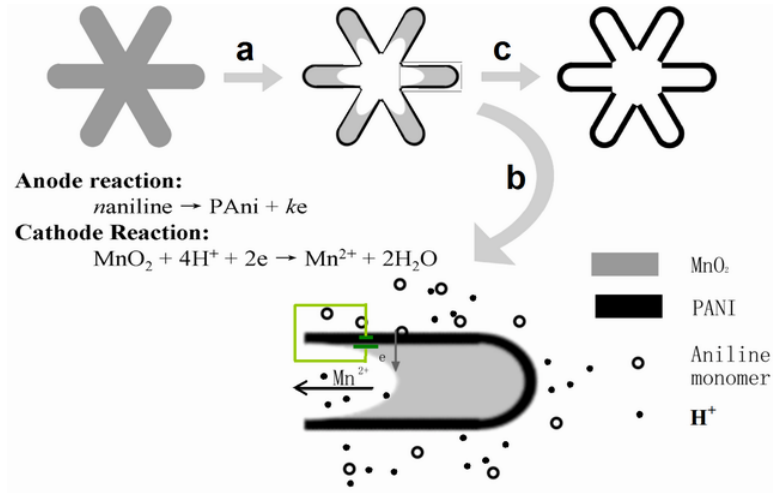
Figure 8. Schematic illustration of the proposed microzone galvanic cell reaction that occurs during the conversion from manganese oxide wire to polyaniline nanotube. a ) The aniline was polymerized on a manganese oxide nanowire surface. b ) The hollow structure developed mainly through the micro-zone galvanic-cell reaction mode. c ) The homogeneous polyaniline tube was finally formed because the whole surface of the polyaniline (Polyaniline) thin film was almost equipotential in the micro-zone galvanic- cell reaction. Reproduced with permission from Wiley-VCH Verlag